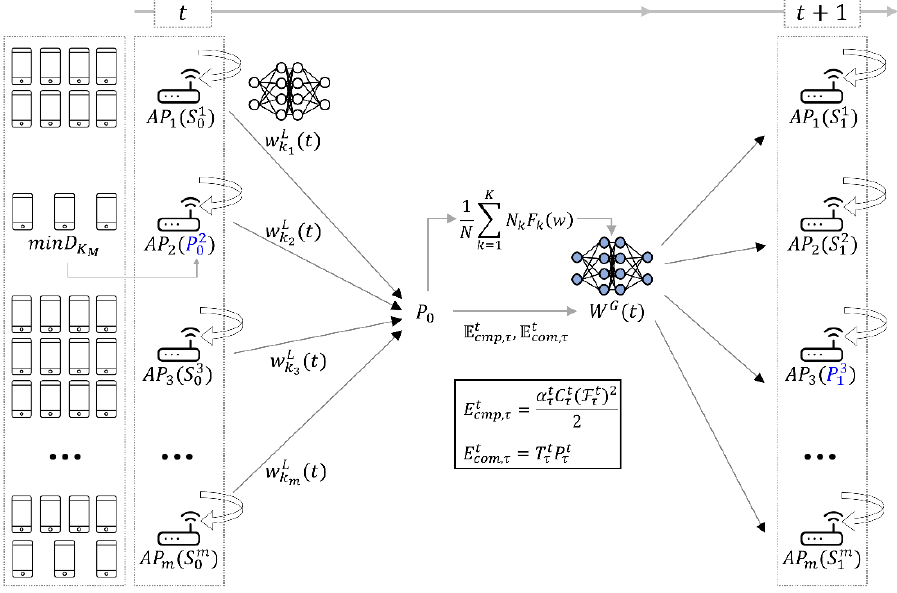
Figure 2. Architecture of the proposed method. The blue P is P-AP of the communication round. The superscript of P means the index of the AP, and the subscript is communication round.